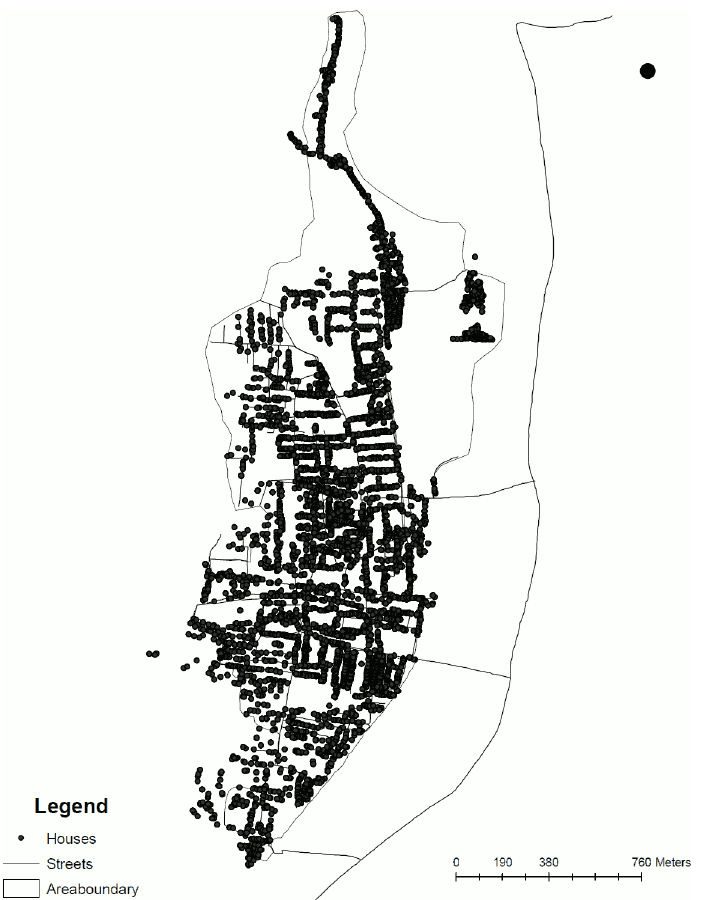
Fig 1. Geographic distribution of study